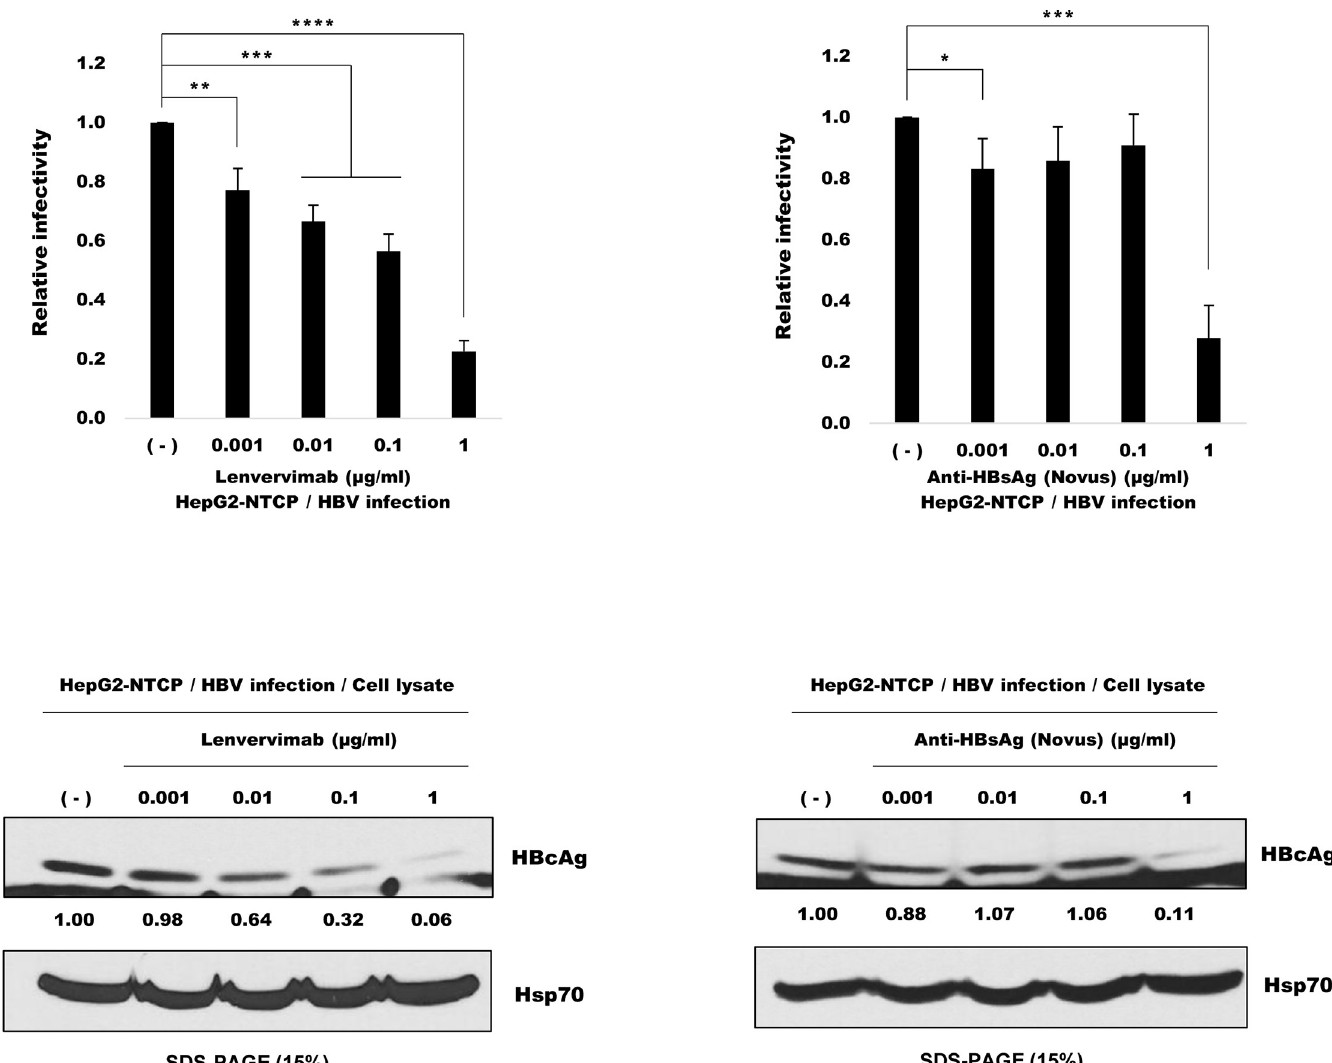
Fig 1. Lenvervimab neutralizes HBV infection in culture. (Upper) HepG2-NTCP cells were infected for 16 h with HBV at 500 Geq/cell in the presence of 0.001~1 microgram/ml of Lenvervimab (shown on the left) or a commercial rabbit polyclonal anti-HBsAg antibody (from Novus Biologicals) (shown on the right). HBsAg secreted into the culture media was measured after 5 days by ELISA. Bars indicate the average value and standard errors of triplicate experiments. P-values were obtained by utilizing the Excel software based on the two-tailed Student’s t-test. P-values indicated are less than 0.05 ( � ), 0.01 ( �� ), 0.001 ( ��� ) and 0.0001 ( ���� ), respectively. (Lower) Intracellular viral core protein (HBcAg) after 5 days was examined by immunoblotting with an anti-HBcAg antibody. Values shown below the blot are the intensity of HBcAg scanned by Image J software (NIH) and normalized with that of the loading control Hsp70.